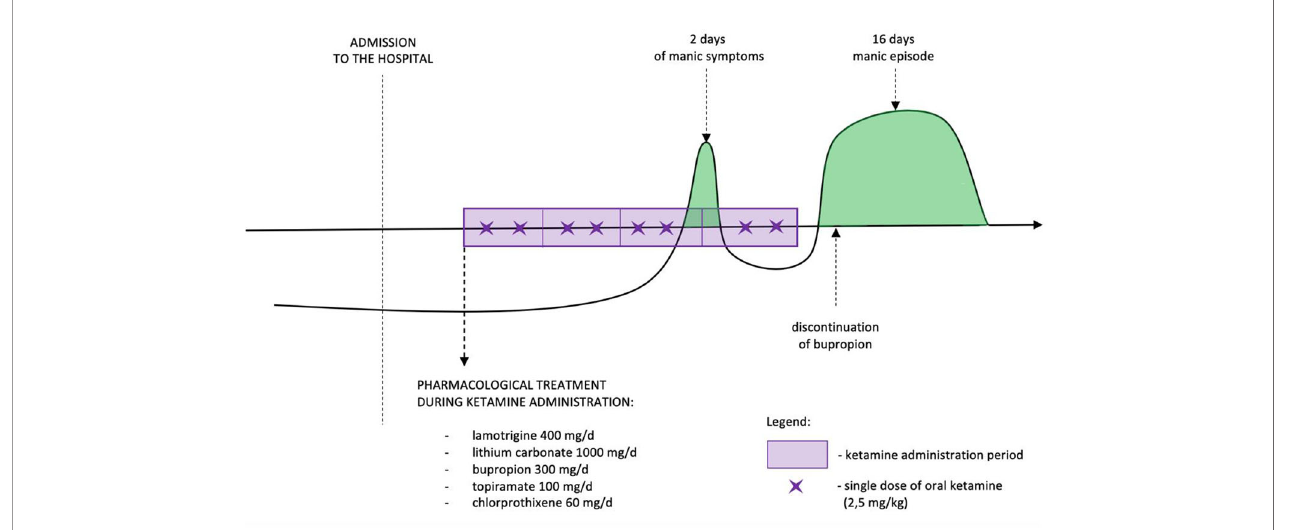
FIGURE 1 | Treatment